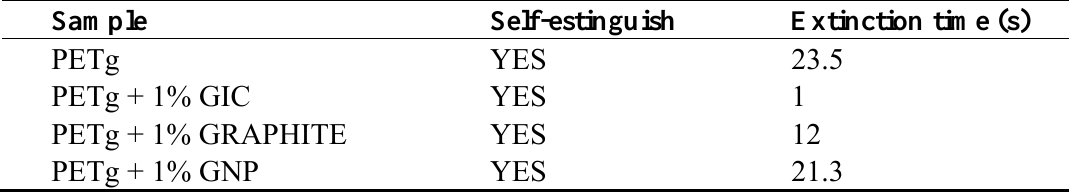
Table 3. Summary of fire resistance behavior of PETg